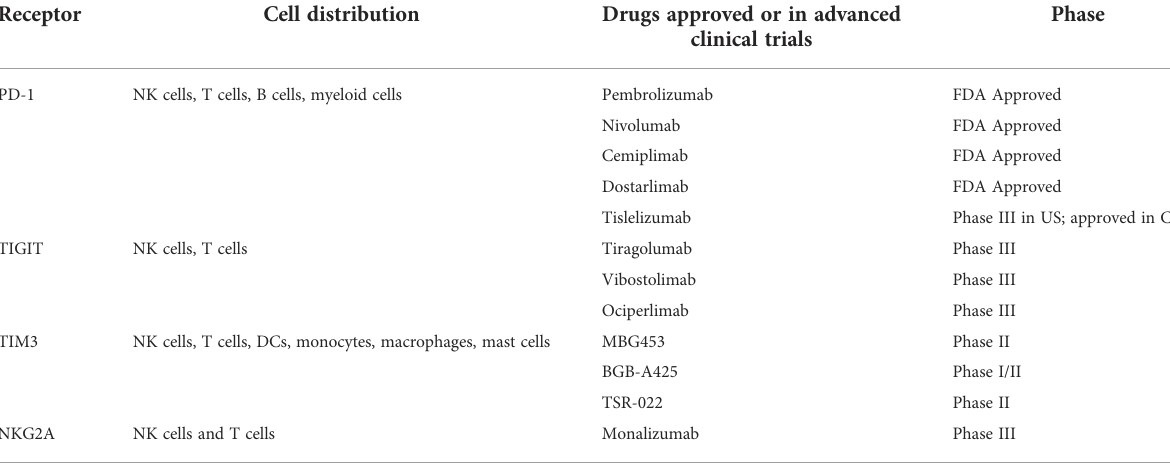
TABLE 2 Selected shared immune checkpoint receptors between NK cells and T cells.